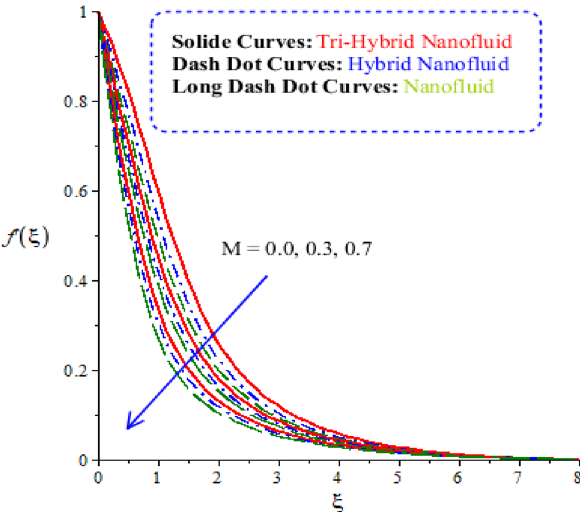
Figure 4. Comparative variation of velocity curves among nanoparticles versus M .